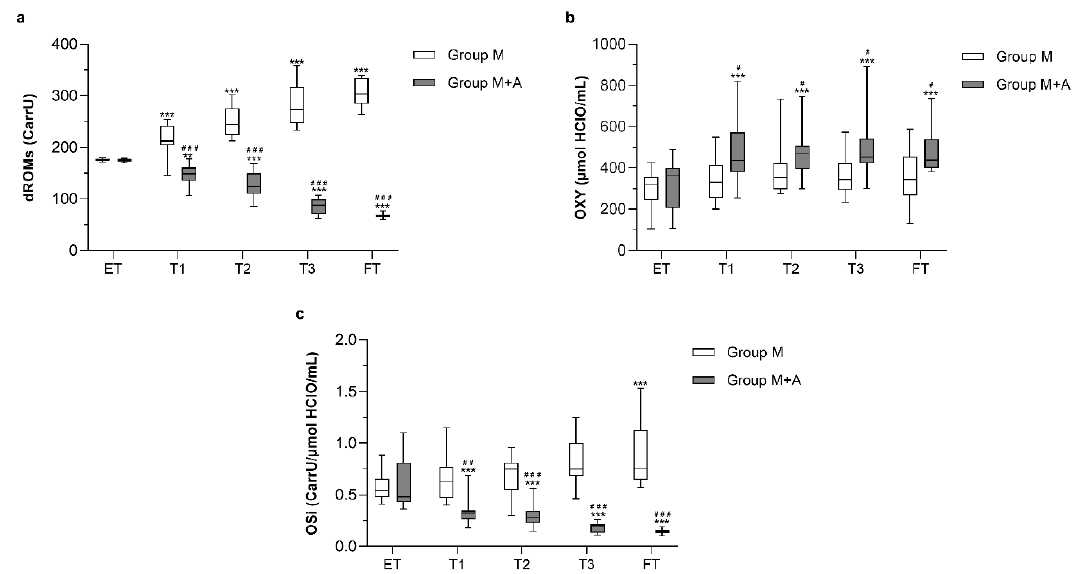
Figure 3. Determinable reactive oxygen metabolites (dROM) ( a ), OXI-adsorbent test ( b ), and OSi values ( c ) in hyperthyroid cats receiving methimazole and placebo (group M, n = 14), or methimazole and antioxidants (group M + A, n = 16). (** p < 0.01 and *** p < 0.001). Hashtags indicate statistically significant di ff erences compared to group M (# p < 0.05, ## p < 0.01, and ### p < 0.001). Statistical analysis was performed by two-way ANOVA for repeated measures followed by Sidak’s posthoc test. ET = enrollment time; T1 = 15 days; T2 = 30 days; T3 = 90 days; FT = finish time (180 days) .